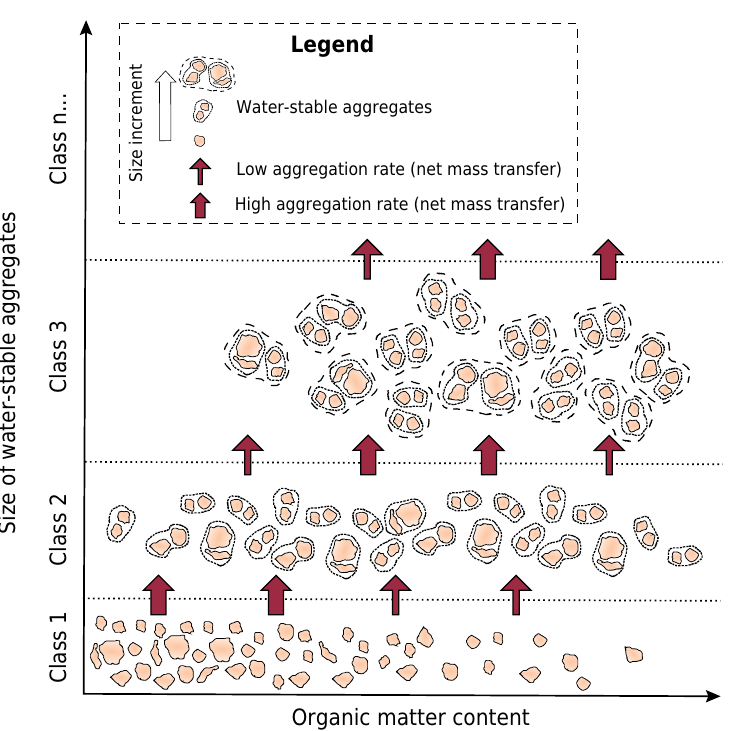
Figure 5. Conceptual model of the aggregation rate